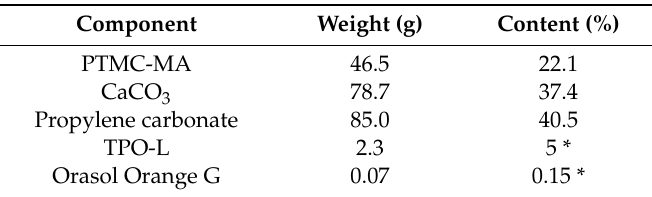
Table 1. Resin formulation for stereolithography.